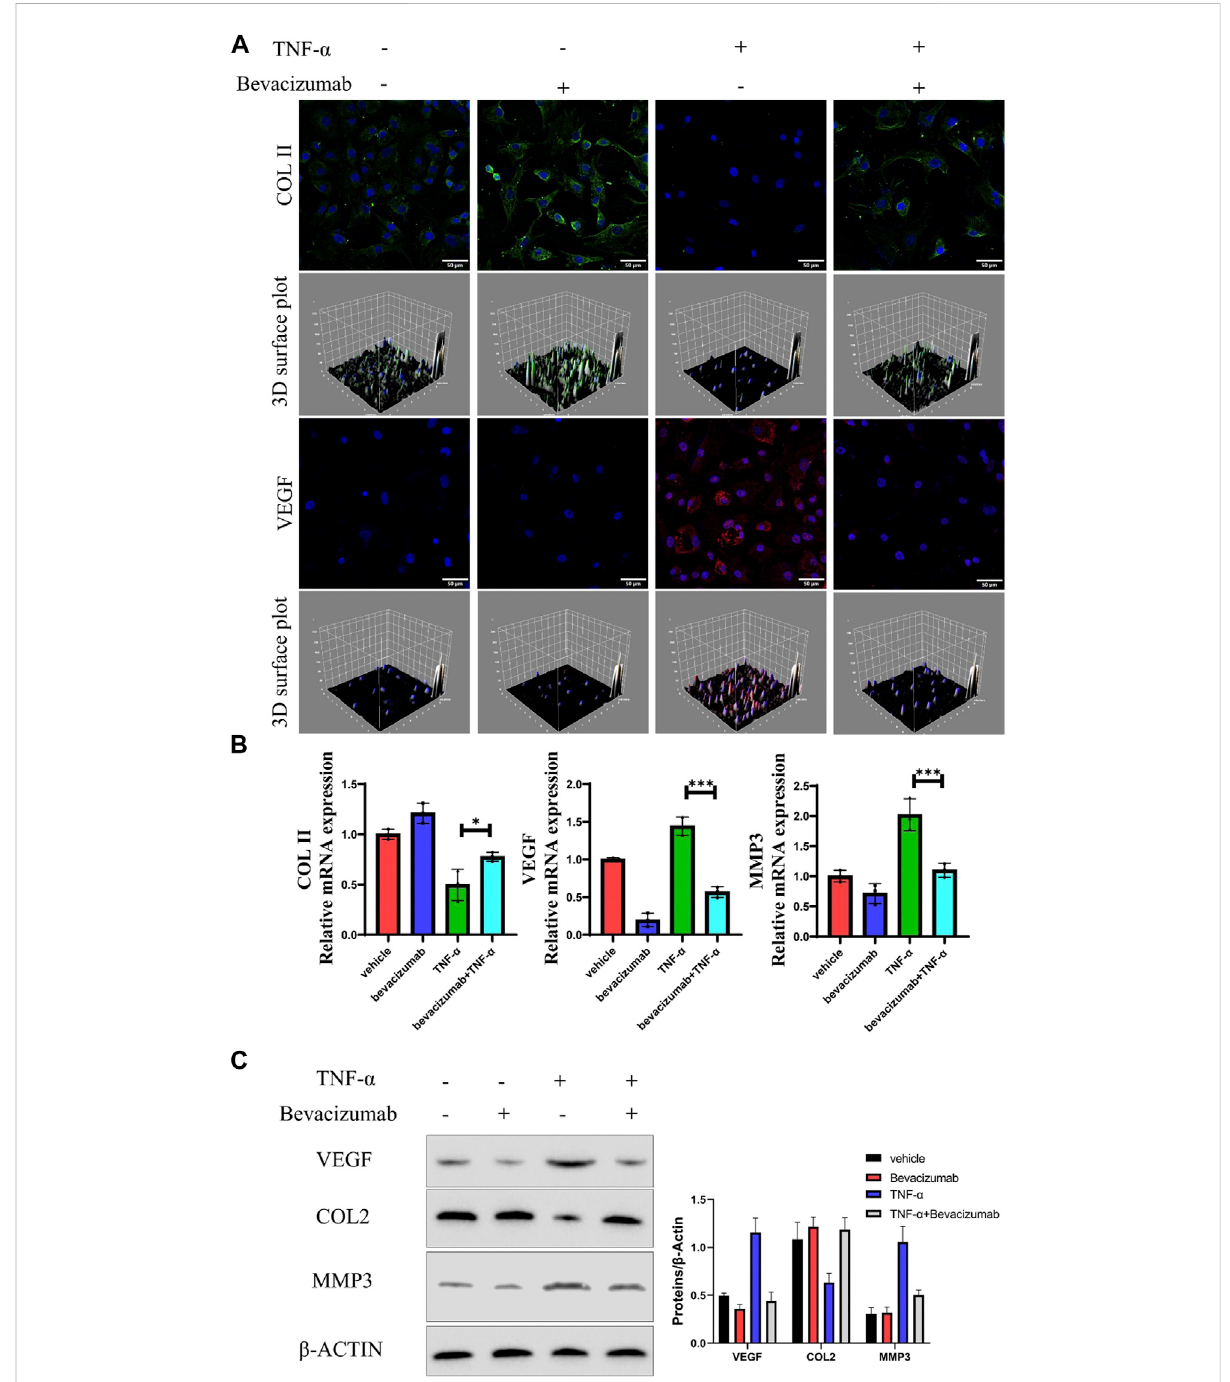
FIGURE 2 Bevacizumab promotes NP cells anabolism by inhibiting VEGF expression. (A) Immuno fl uorescence analysis of COL II (green) and VEGF (red) production of rat NP cells in 4 groups. Scale = 50 μ m. (B) The relative expression levels of mRNA in the 4 groups were assessed by RT-qPCR. (C) Western blot analysis of VEGF, COL II and MMP13 proteins are displayed in 4 groups. data are presented as mean ± SD (n = 5). * p < 0.05; *** p < 0.01. Scale bar = 50